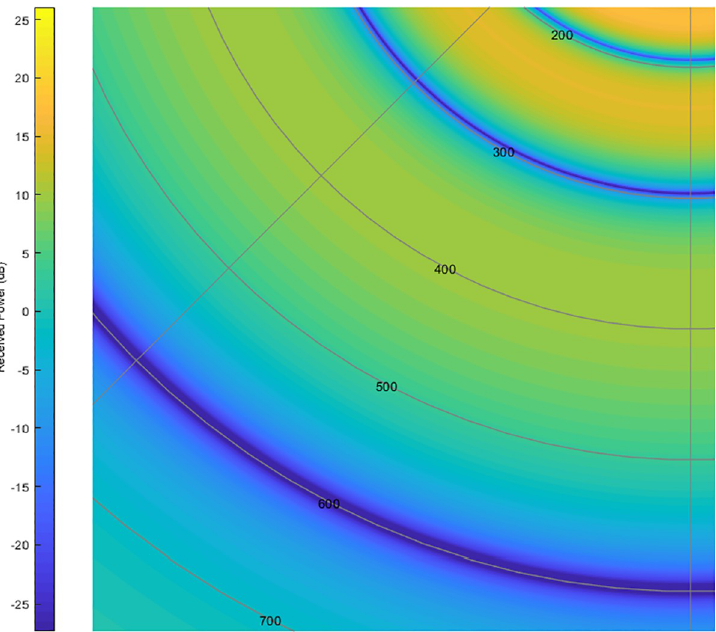
Fig 10. UAV’s received signal power in AUT environment (detail on 300–600 m